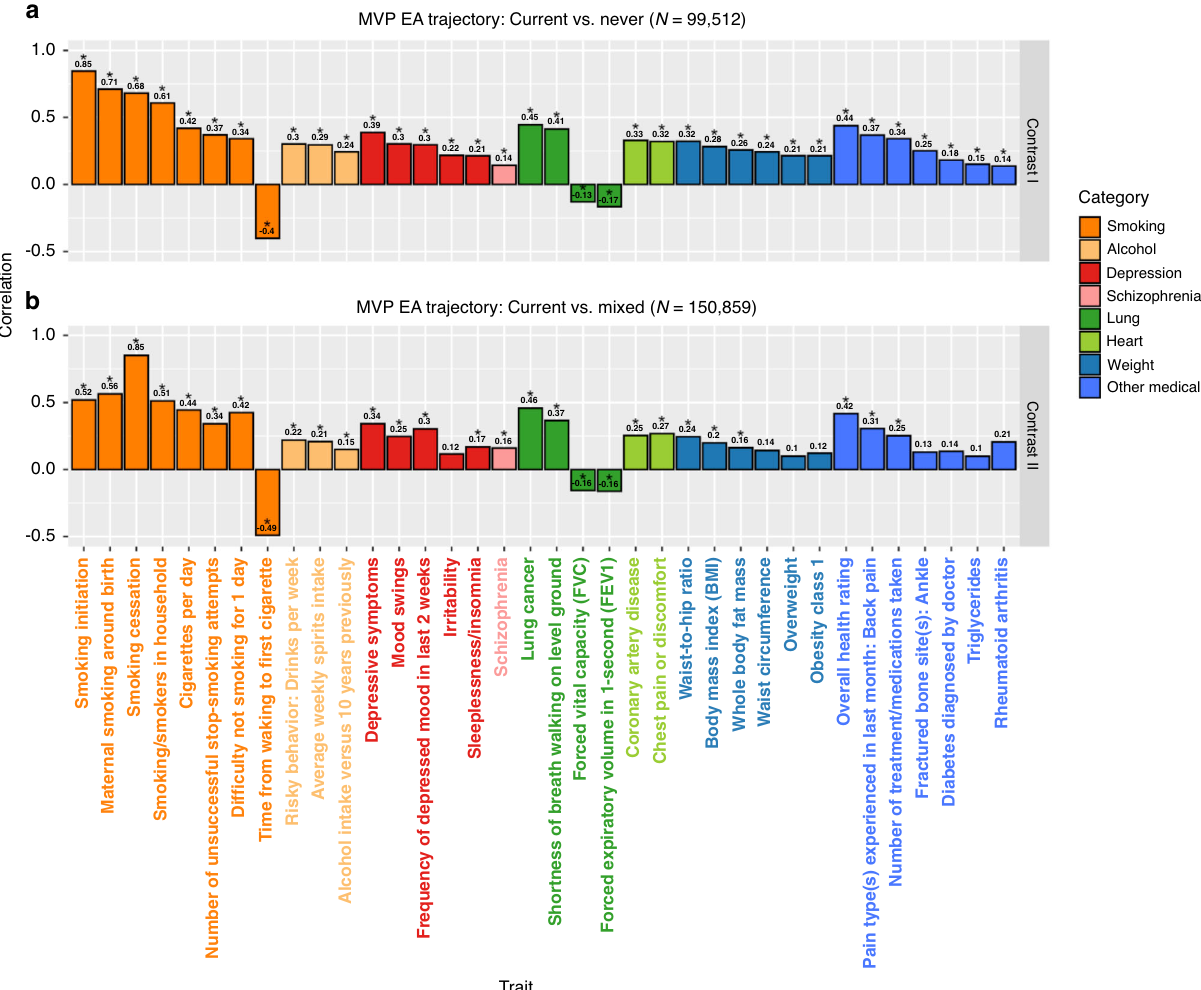
Fig. 4 Genetic correlations between smoking trajectory contrasts and multiple complex traits. Complex traits with signi fi cant genetic correlations with smoking trajectory contrast I (current vs. never ( a )) and contrast II (current vs. mixed ( b )) in European American samples in the Million Veteran Program. Asterisk indicates signi fi cance after Bonferroni correction with a Wald test p value cutoff at 0.05/524/2 = 4.8 × 10 − 5 . Detailed information on the exact p values, data source, and sample sizes for each complex trait is summarized in the Supplementary Data